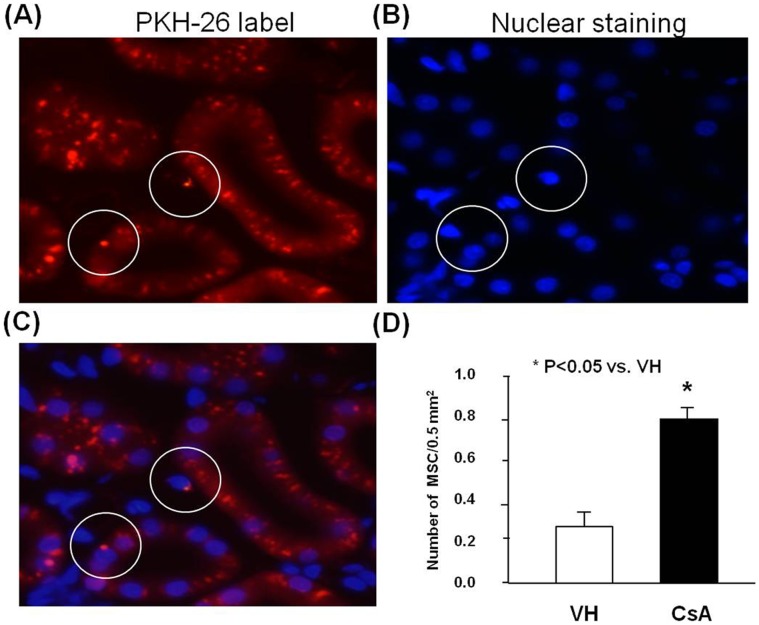
Homing of PKH-26 labeled hATMSCs to the kidney tissue.(A) The representative of PKH-26 label (B) The staining for nuclei using (DAPI) (C) The overlay of (A) and (B) showed homing of PKH-26 labeled hATMSCs in renal interstitial tissue. PKH-26 staining merged with nuclear staining (in the circle), indicating PKH-26 labeled hATMSCs. (Original magnification x400 in A through C) (D) The quantization of PKH-26 labeled hATMSCs. Labeled cell was more frequently detected in CsA treated group compared to VH group. hATMSCs; human adipose tissue derived mesenchymal stem cells DAPI; 4′,6-Diamidino-2-Phenylindole.